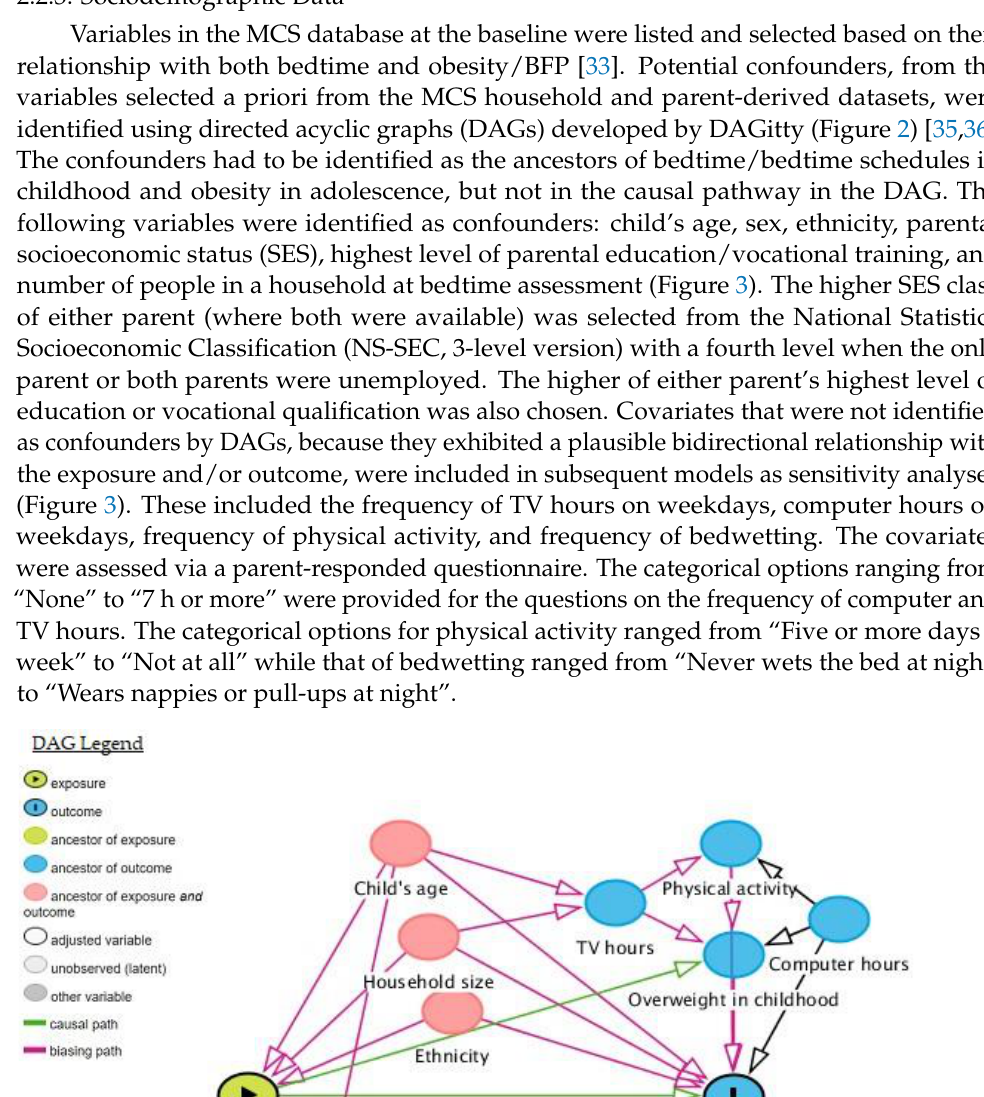
Figure 3. Directed acyclic graph (DAG) for the relationship between bedtime in childhood and obe- sity risk in adolescence showing selected confounders. DAG legend is shown on the top left-hand corner.